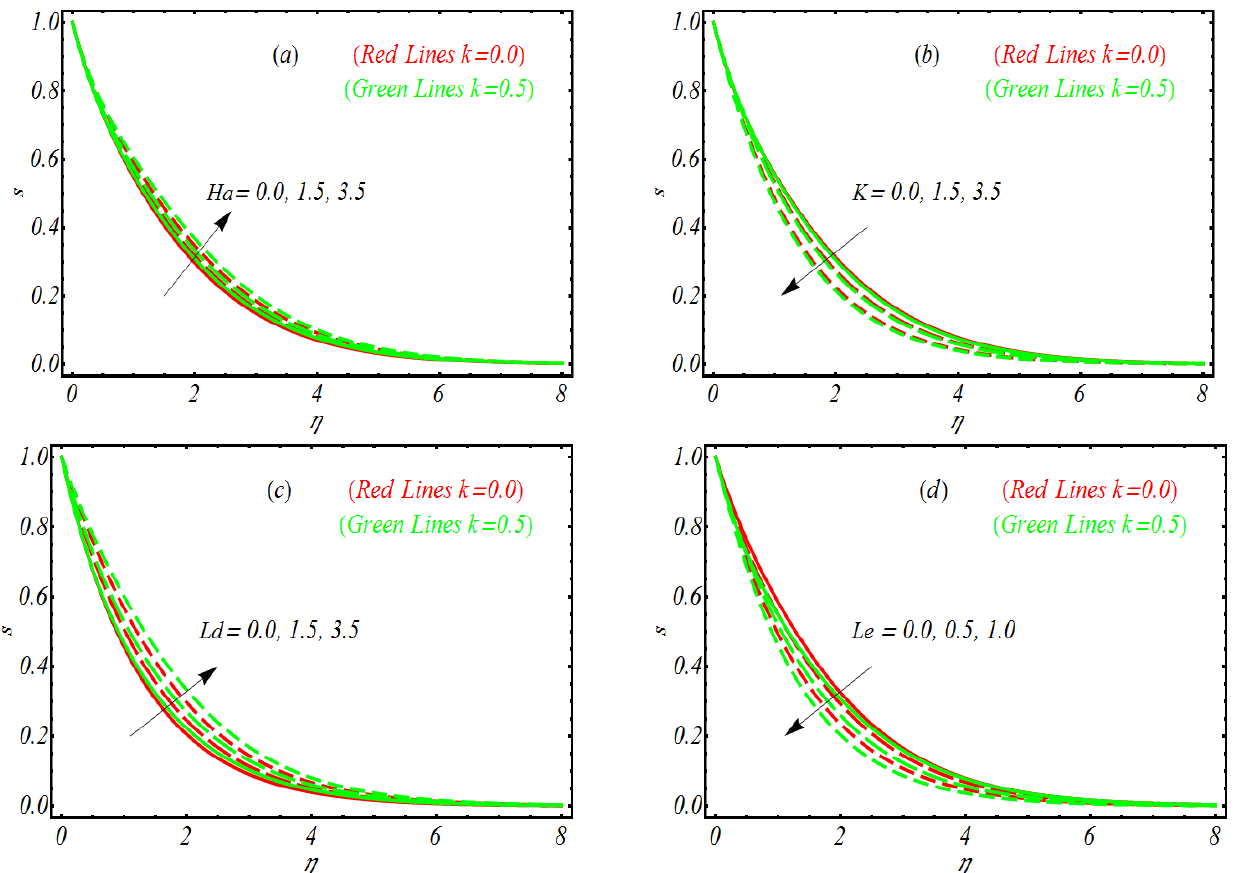
Figure 3. Solutal concentration profile for ( a ) Ha , ( b ) K , ( c ) Ld and ( d ) Le